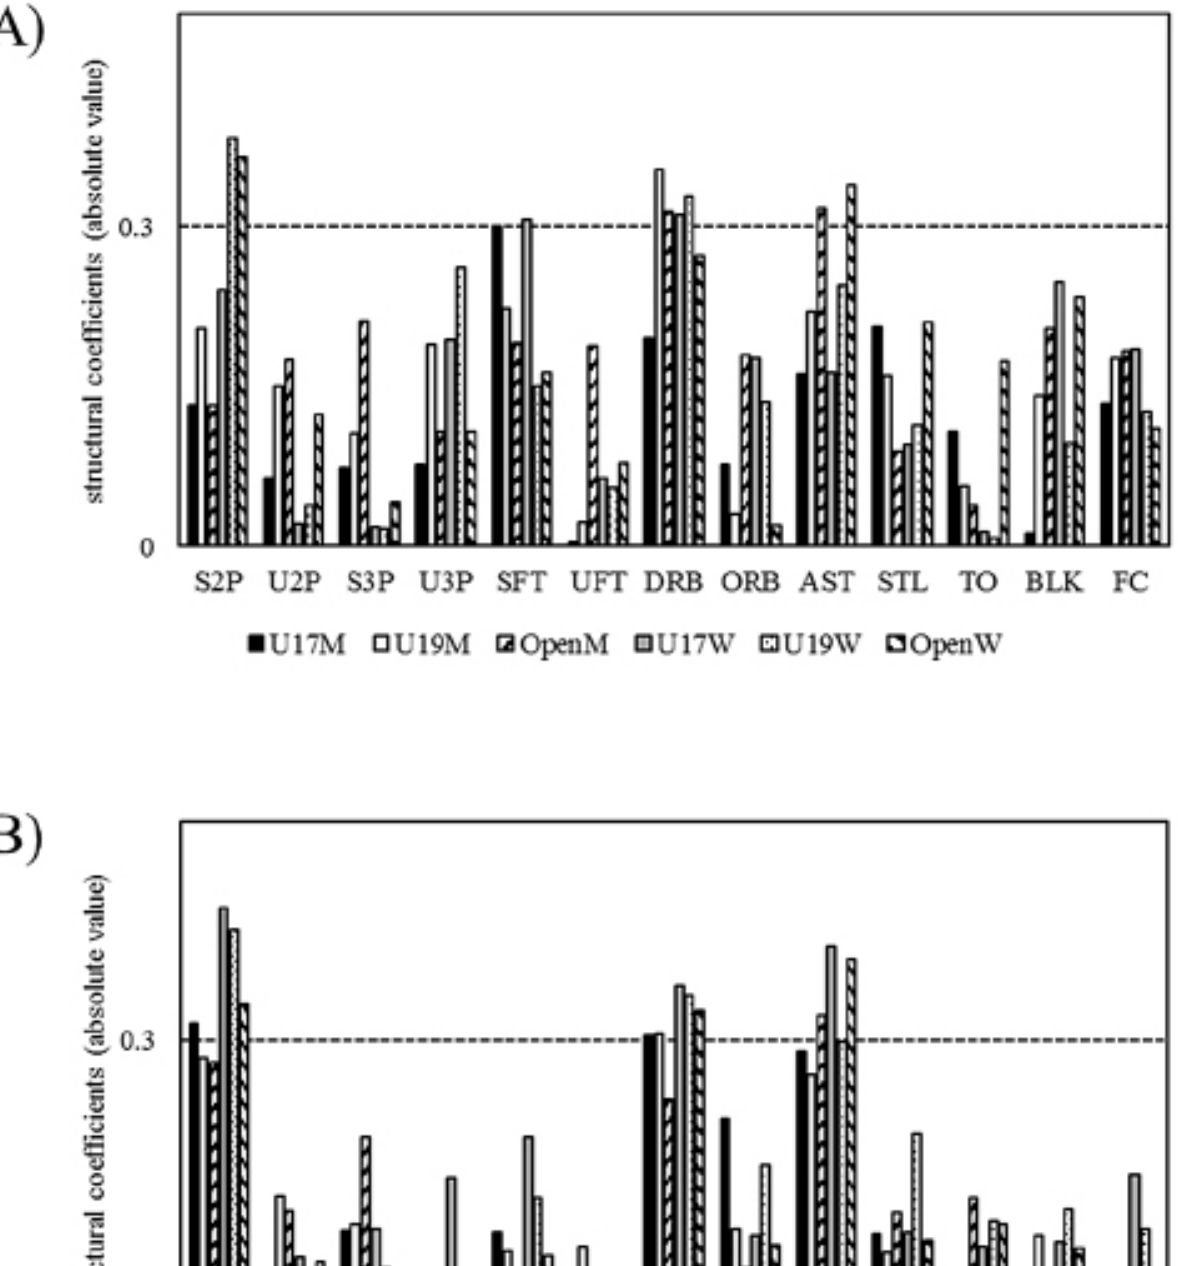
Figure 1. Structural coefficients (SC) of game-related statistics in balanced (A) and unbalanced (B) games. S2P, successful 2-point field goals; U2P, unsuccessful 2-point field goals; S3P, successful 3-point field goals; U3P, unsuccessful 3-point field goals; SFT, successful free throws; UFT, unsuccessful free throws; DRB, defensive rebounds; ORB, offensive rebounds; AST, assists; STL, steals; TO, turnovers; BLK, blocks; FC, fouls committed; M, men; W, women. |SC| ≥ 0.30 was considered relevant for